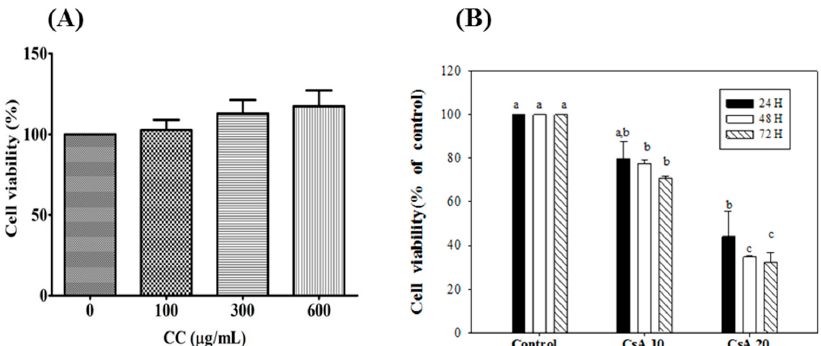
Figure 7. Effects of CCM ( A ) and Csa ( B ) on viability of HK-2 cells. Each value represents the mean ± SEM (n = 3). Different letters indicate significant differences between groups ( p < 0.05).